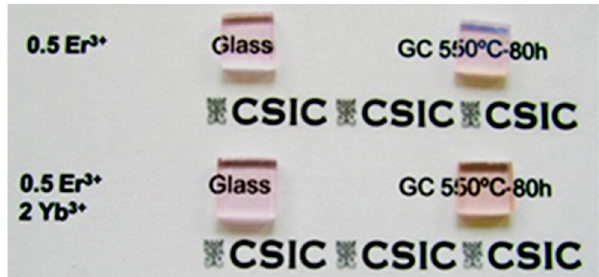
Figure 1. Transparent samples of 0.5Er 3+ -doped and 0.5Er 3+ –2Yb 3+ -codoped 70Si7Gd glass and glass–ceramics (GCs) heat-treated at 550 °C-80 h.